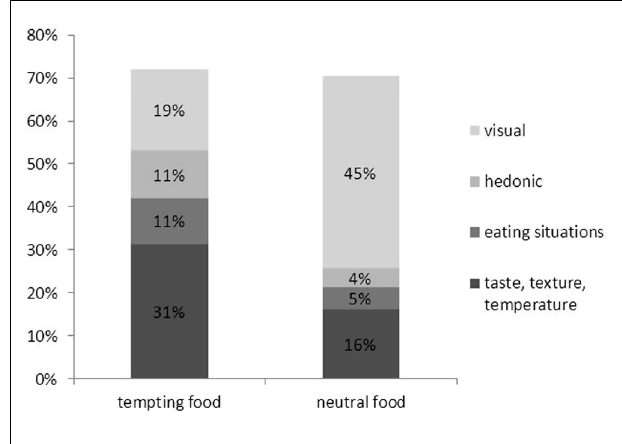
FIGURE 4 | Percentages of eating simulation and visual features, constituting different profiles for tempting and neutral